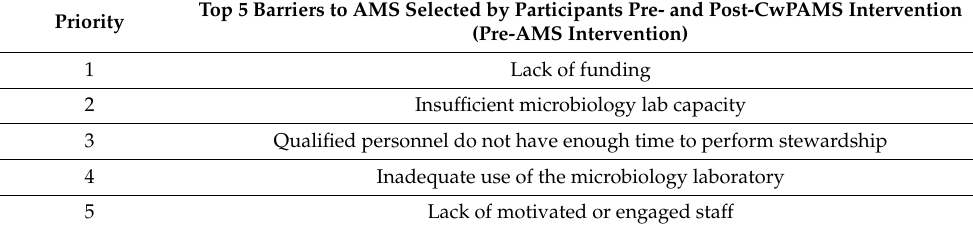
Table 3. Top five barriers to AMS pre- and post-AMS intervention.